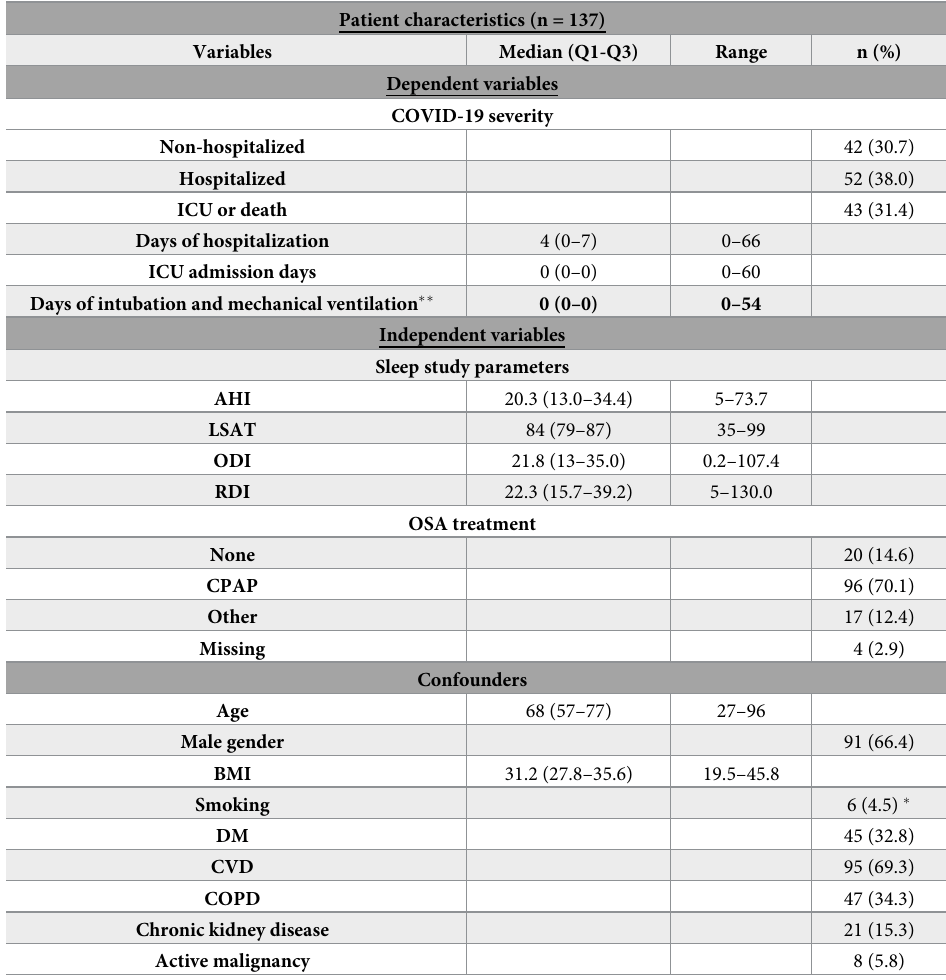
Table 2. Demographic variables of the study